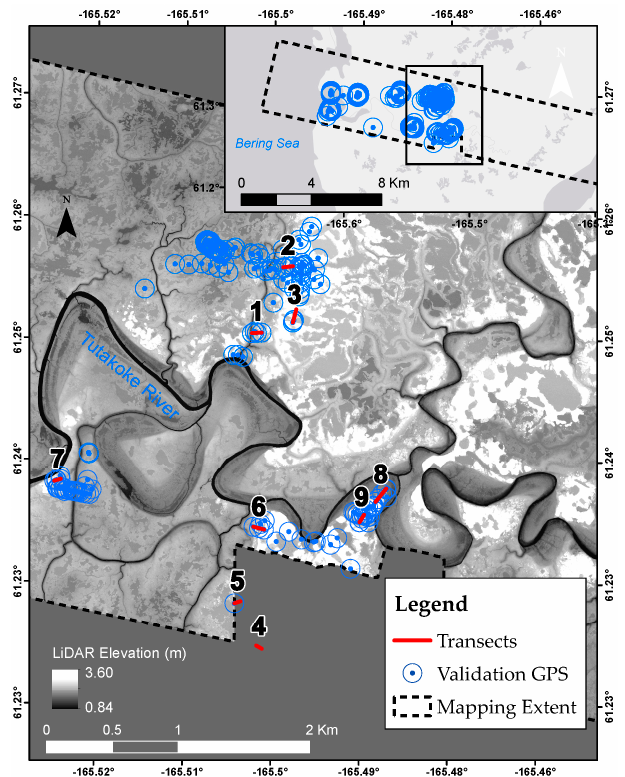
Figure 4. Locations of transects, field validation sampling points, and the mapping extent (dashed line) near the Tutakoke River, YKD. The thaw-depth transects (bold numbers) are shown in red, and the field validation points are shown in blue.